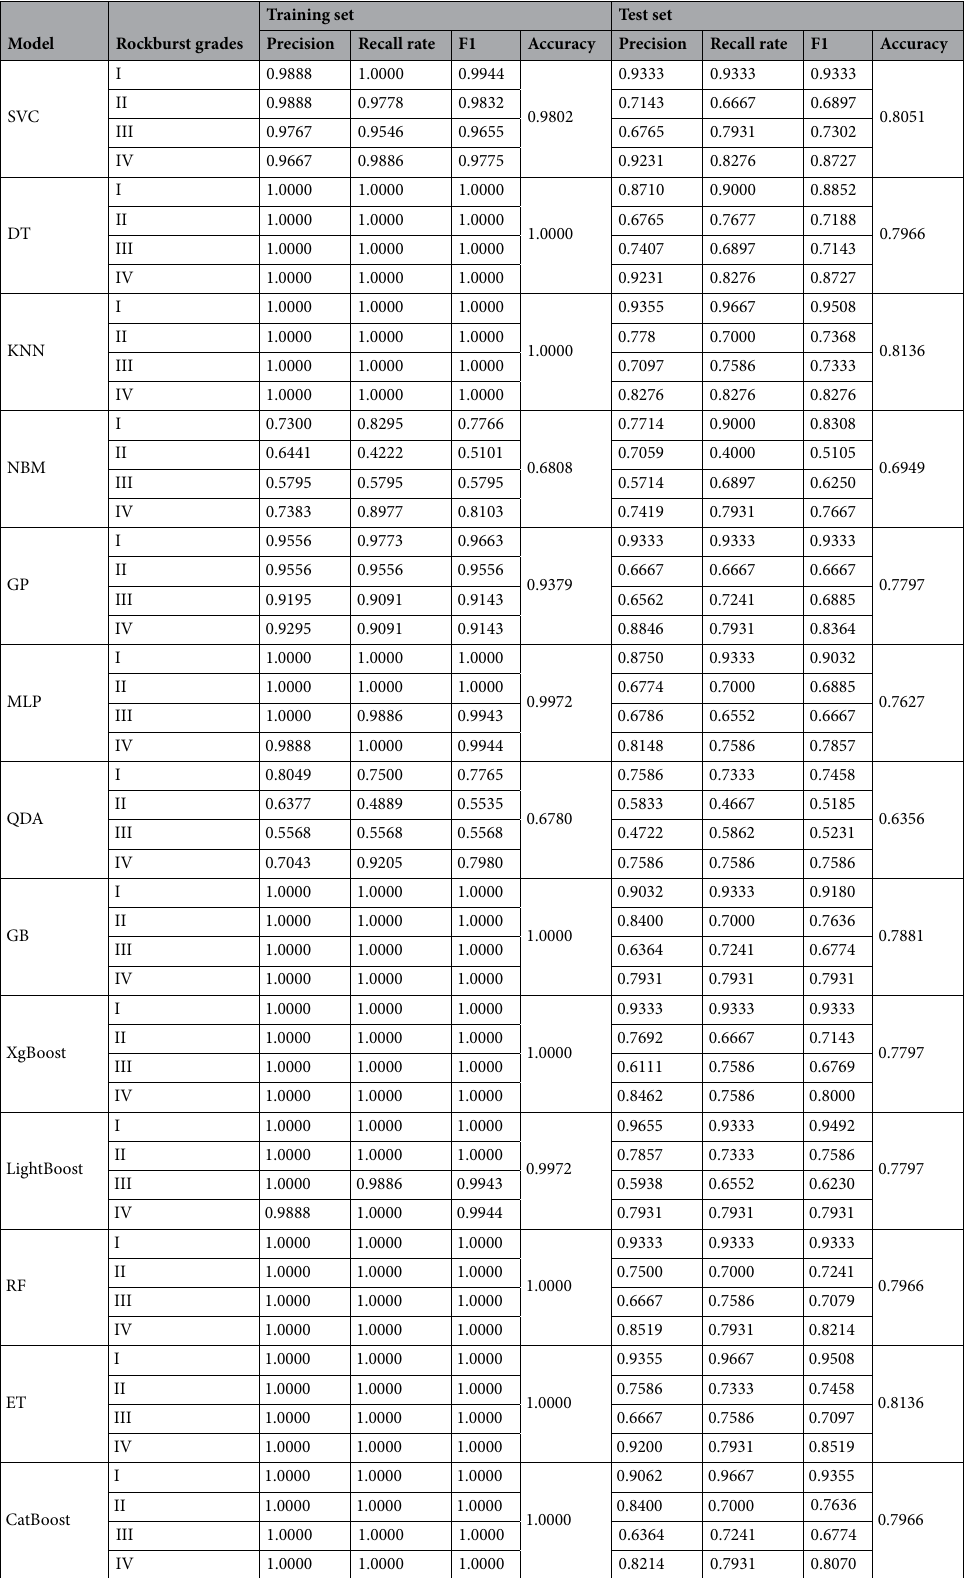
Table 4. Prediction results with the rockburst dataset after